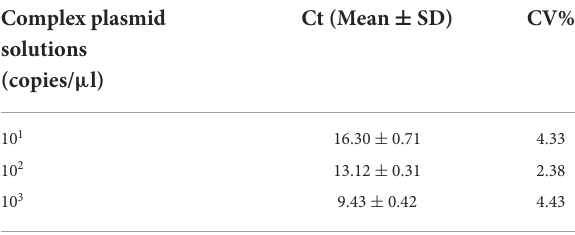
TABLE 3 Real-time RT-RAA repeatability assay of complex plasmid solutions. Complex plasmid